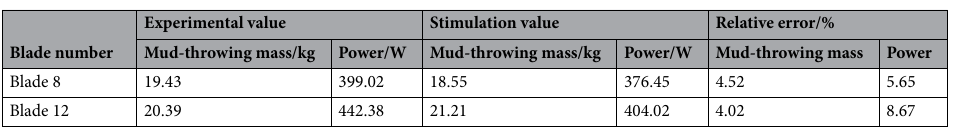
Table 4. Bench test results.